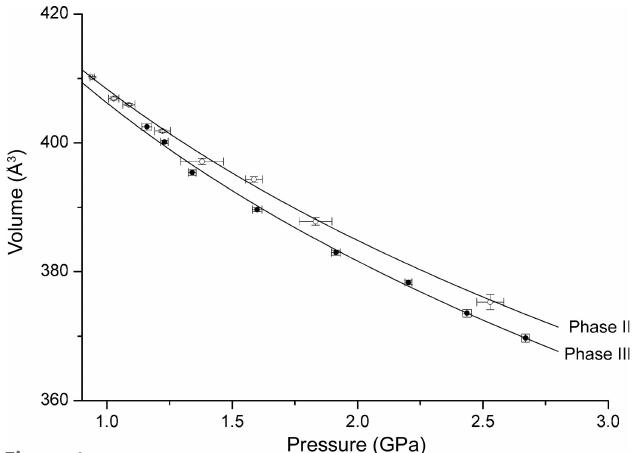
Figure 4 Variation of the unit-cell volumes of pyridine-d 5 phases II (open circles) and III (closed circles) with pressure, fitted to the third-order Birch– Murnaghan equation of